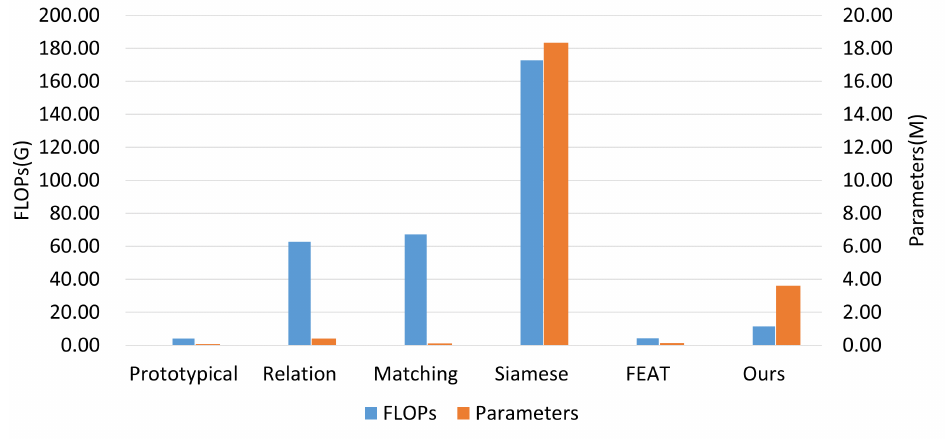
Figure 15. Comparison of the number of parameters and FLOPs between different